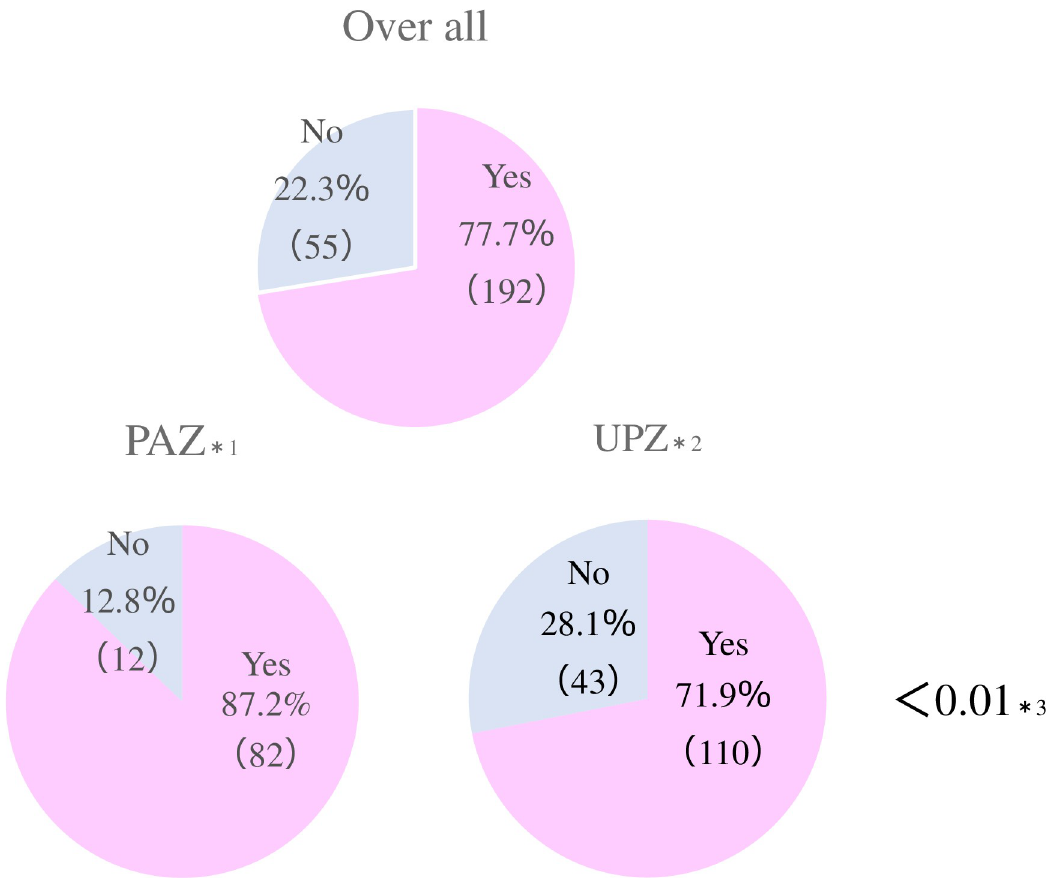
Fig 2. Frequency of residents in the PAZ and UPZ who were aware of SI. � 1. Awareness of SI in the PAZ, � 2. Awareness of SI in the UPZ, � 3. Chi-square test for the PAZ and UPZ, PAZ = Precautionary Action Zone, UPZ = Urgent Protective action planning